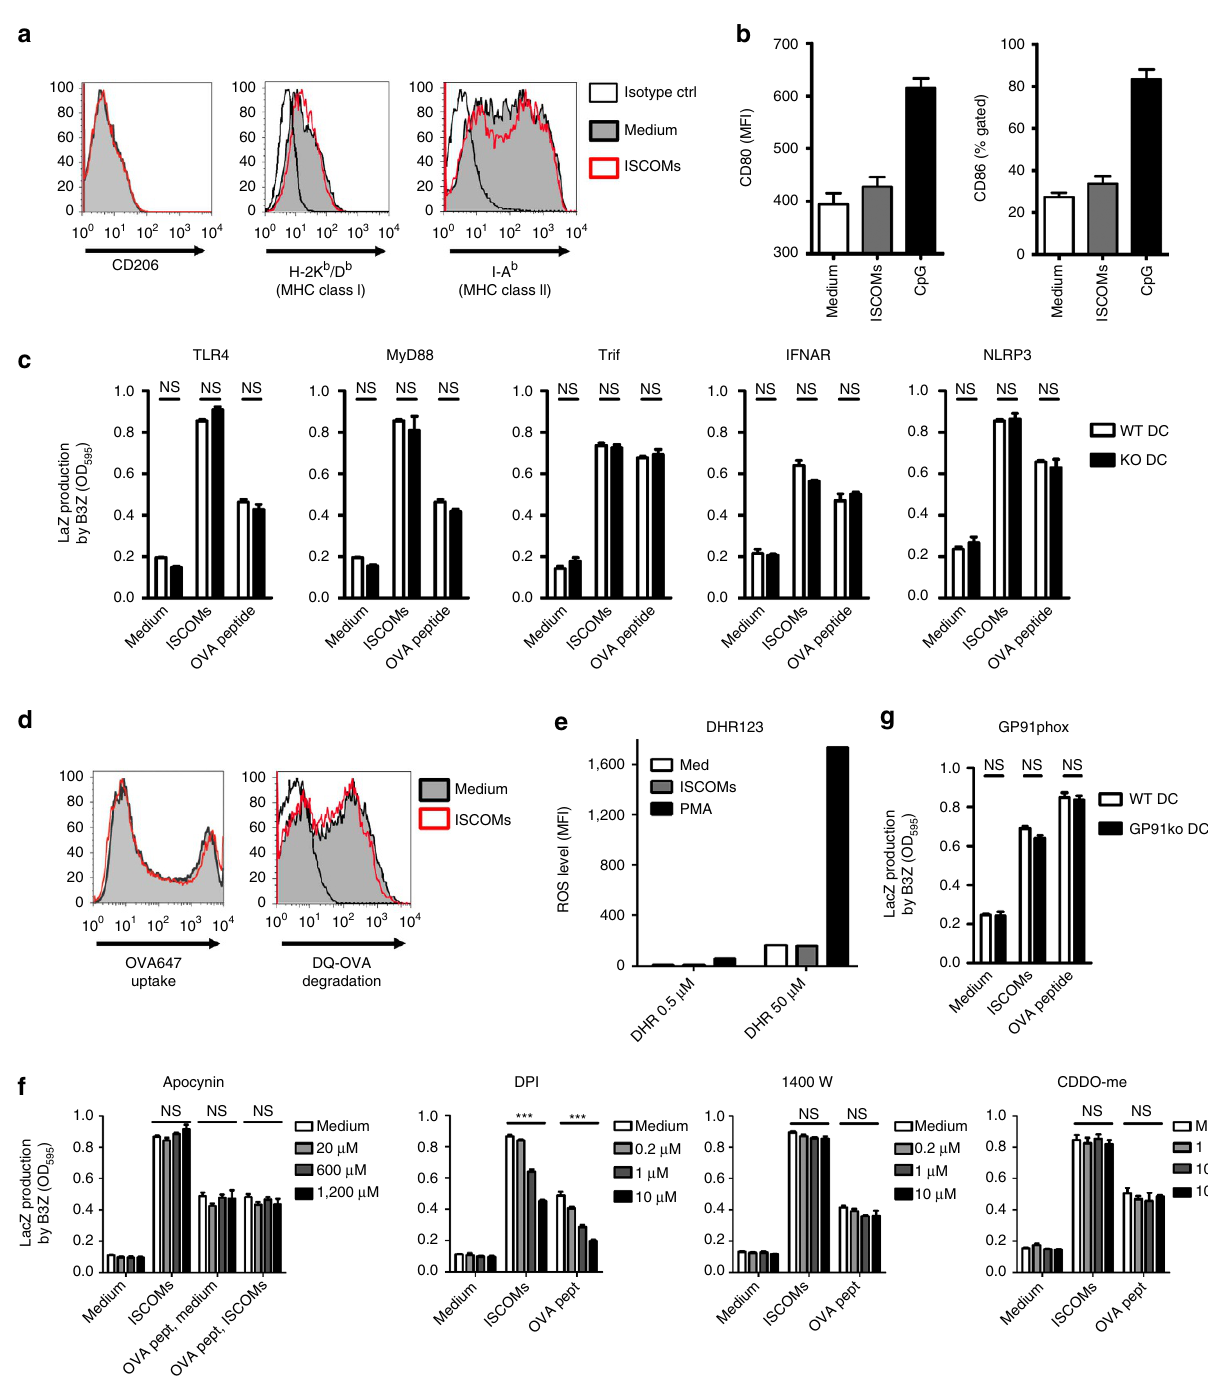
Figure 2 | SBA-induced cross-presentation is independent of co-stimulation or ROS. ( a ) FACS analysis of surface markers CD206 (mannose receptor), MHC-I, and MHC-II. GM-CSF BMDCs were exposed for 5h to ISCOMs or medium, and processed for FACS staining. Open black lines represent the corresponding isotype controls. Filled grey lines show the medium-treated cells, while the open red lines are the ISCOM treated samples. ( b ) FACS analysis of DC maturation markers CD80 and CD86 after 18h stimulation with ISCOMs or 1 m gml (cid:2) 1 CpG. ( c ) Bone-marrow of indicated knockout mice was used to generate GM-CSF BMDCs. Cells were exposed for 5h to medium or ISCOMs, washed and co-cultured o/n with B3Z cells. External peptide pulsing (5pgml (cid:2) 1 , 30min) was used to control for viability and/or MHC-I levels. ( d ) Antigen uptake and processing as analysed by FACS. BMDCs were given 0.25mgml (cid:2) 1 OVA coupled to the fluorophore Alexa647, or 1 m gml (cid:2) 1 DQ-OVA, during the 5h exposure time to medium or ISCOMs. DQ-OVA will start to fluoresce once degraded. ( e ) Total cellular reactive oxygen species (ROS) were measured using the DHR123 probe. GM-CSF cultured BMDCs were plated in serum-free medium and pretreated for 10min with 0.5 or 50 m M dihydrorhodamine 123. Next, ISCOMs or 1 m gml (cid:2) 1 PMA was added and cells were incubated for 45min before analysis by FACS. ( f ) In vitro cross-presentation in the presence of NADPH oxidase inhibitors. Indicated compounds and concentrations were added during the 5h exposure period to ISCOMs. ( g ) In vitro cross-presentation using Gp91phox (cid:2) / (cid:2) bonemarrow DCs. Data in ( e ) represent single values in titration, whereas the other data show means from triplicates with s.e.m. Data are representative figures from two to three individual experiments. Statistical analyses were performed using two way ANOVA with post hoc Bonferroni